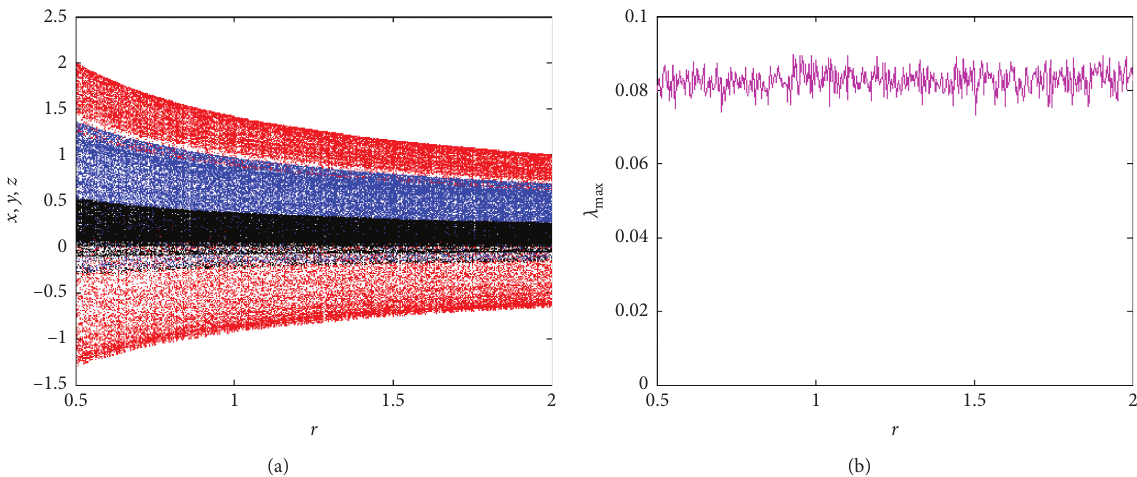
Figure 19: Bifurcation diagrams (a) and largest Lyapunov exponent (b), illustrating the change in amplitude of the variables x , y , and z (in red, blue, and black, respectively) as a function of the parameter r , without alteration of the properties of the system. The parameters b , w f , k , and m are set to 0.3, 0.5, 1.6, and 0.0, respectively.